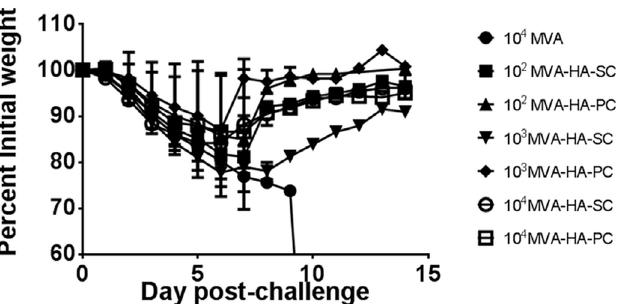
Fig 5. Pathogenesis of influenza rgA/Viet Nam/1203/04 virus after single low dose vaccination via the SC and PC routes. Groups of mice were vaccinated with a single dose of MVA-HA at doses of 10 2 , 10 3 , or 10 4 pfu, via the subcutaneous and percutaneous routes. A control group was vaccinated subcutaneously with 10 4 pfu of MVA vector. All mice were challenged with influenza rgA/Viet Nam/1203/2004 virus three weeks after vaccination and weighed daily for 2 weeks. Mean weight changes after challenge are shown. Each data point is the average of two independent experiments. Error bars represent standard